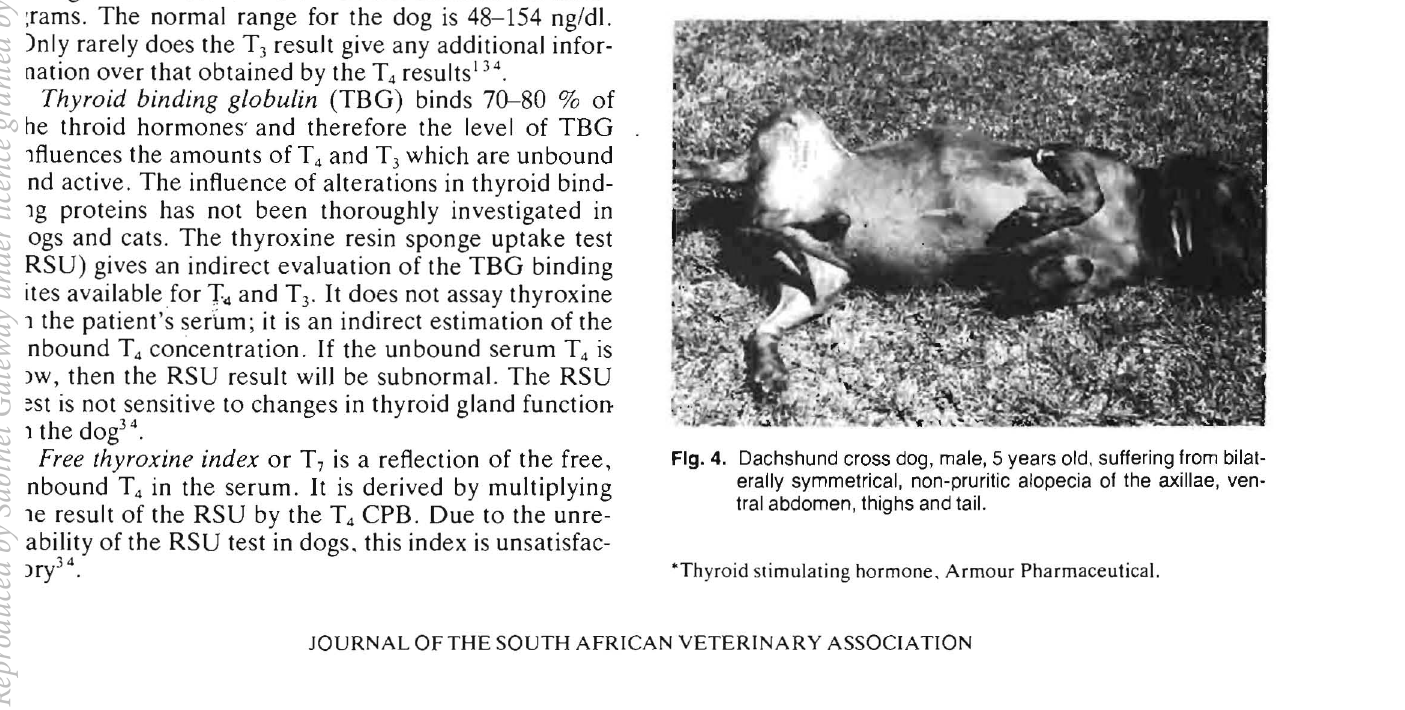
Fig. 4. Dachshund cross dog, male, 5 years old. suffering from bilat erally symmetrical, non-pruritic alopeCia of the axillae, ven tral abdomen, thighs and